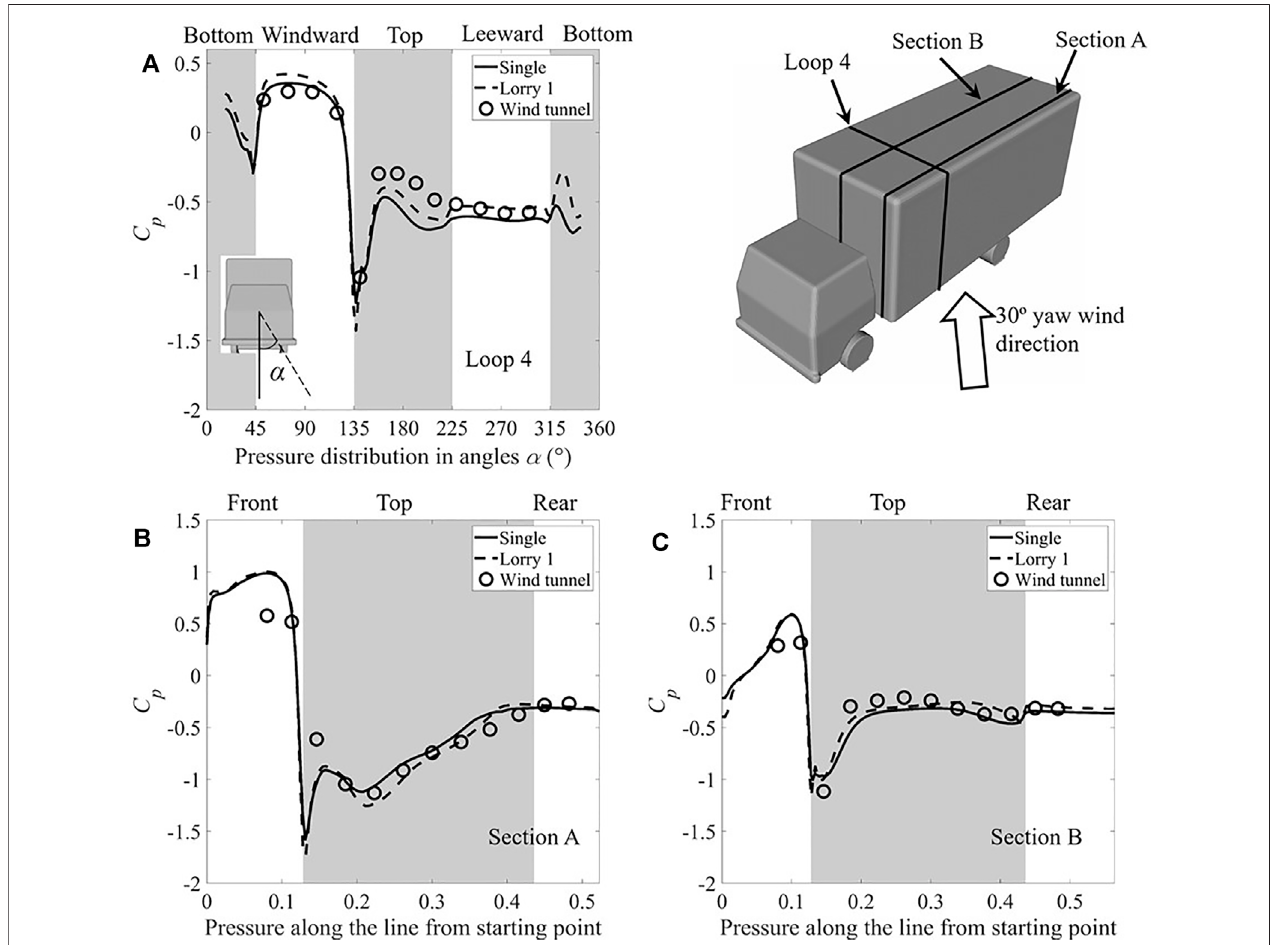
FIGURE 4 | C p distribution along cross-sectional loops on the lorry box (A) . loop four at x/L = 0.365; (B) . section A at y/L = -0.4; (C) section B at y/L = 0.